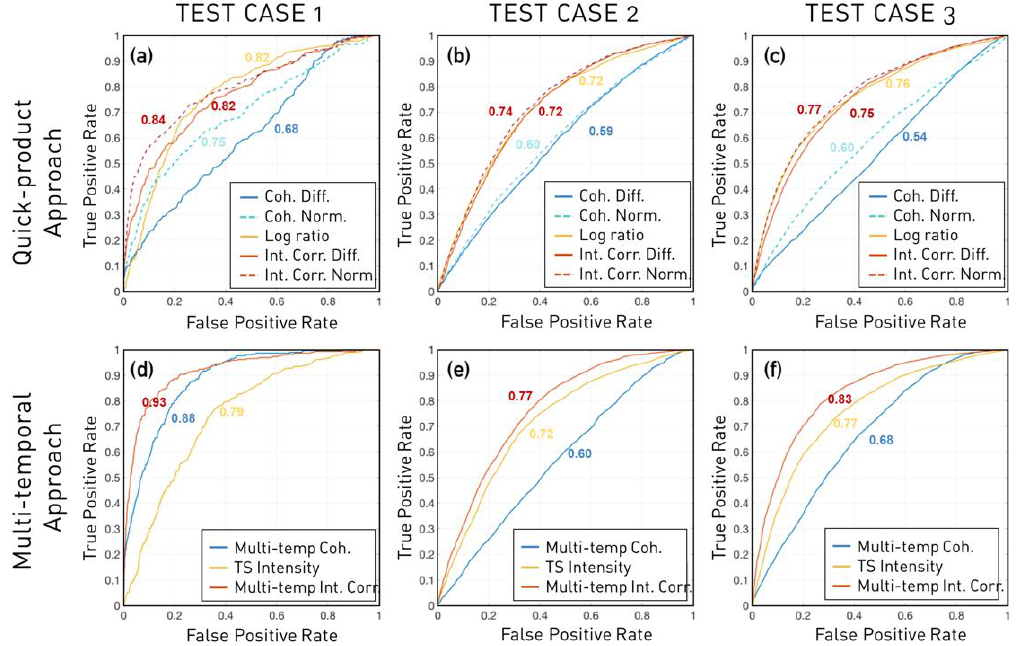
Figure 8. Receiver Operating Characteristic (ROC) curves of ( a – c ) the quick-product and ( d – f ) multi-temporal approaches corresponding test cases 1 ( a , d ), 2 ( b , e ) and 3 ( c , f ). The numbers on the graphs represents Area Under Curve (AUC) values.